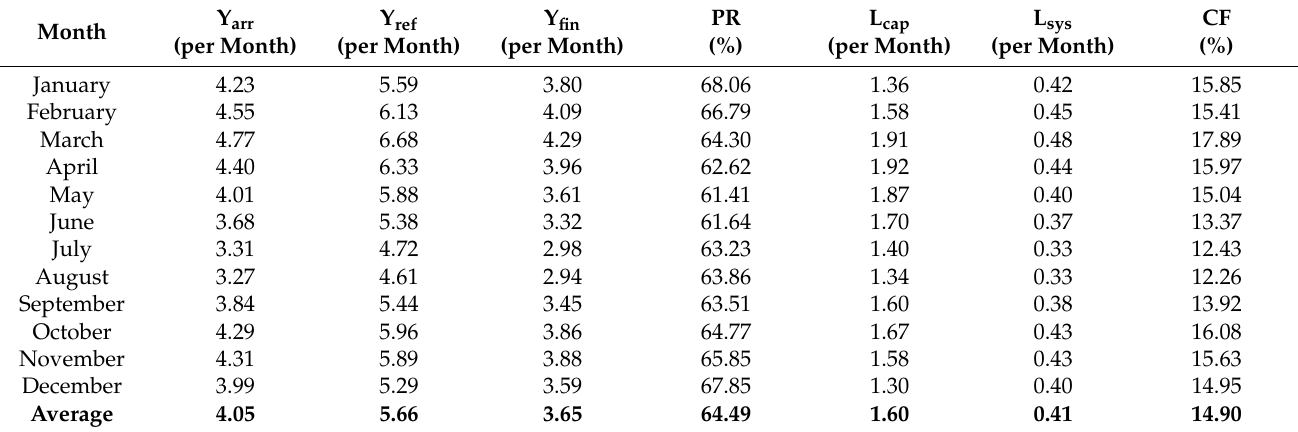
Table 7. Performance index of the SPV system at the selected